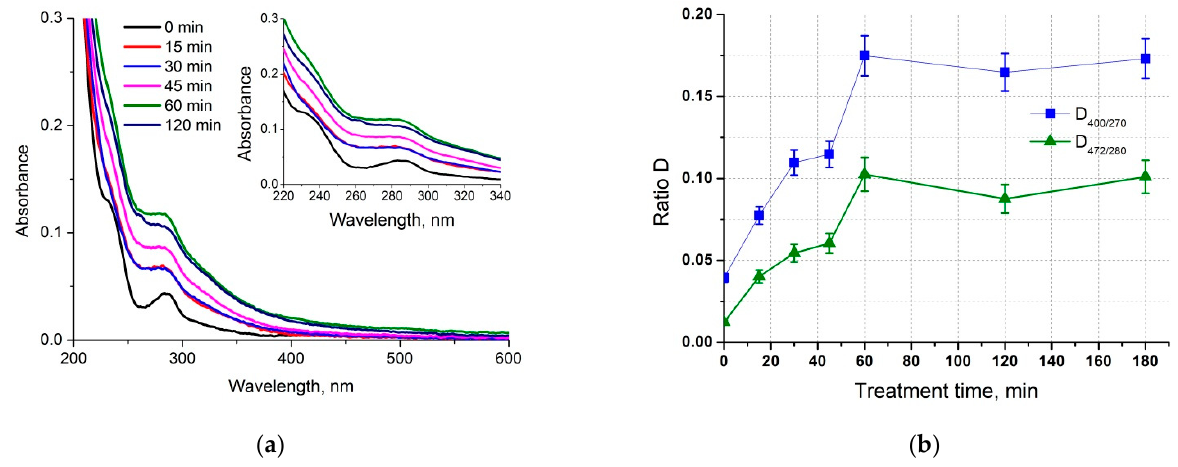
Figure 2. UV-absorption spectra, normalized by the OM content ( a ) and absorbance ratios D 280/472 and D 270/400 ( b ) of LH sampled at different treatment time.